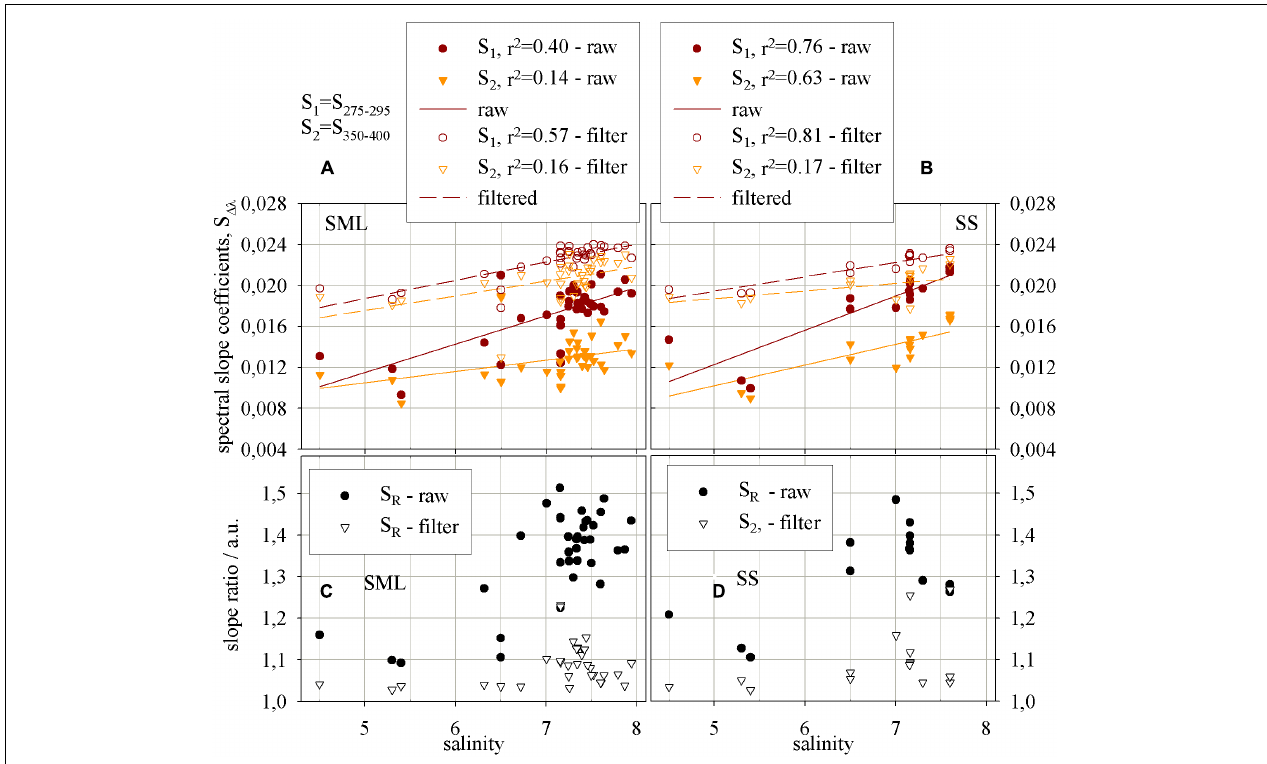
FIGURE 4 | The relations, for the SML and SS, respectively, between salinity and (A,B) the spectral slope and (C,D) the slope ratio coefficients. Spectral slope coefficients increase (i.e., molecular weight decreases) with raising salinity, for ‘raw’ and filtered samples, in (A) the SML and (B) SS. The report of the equations applied to reach the results presented on the graphs – Table 3